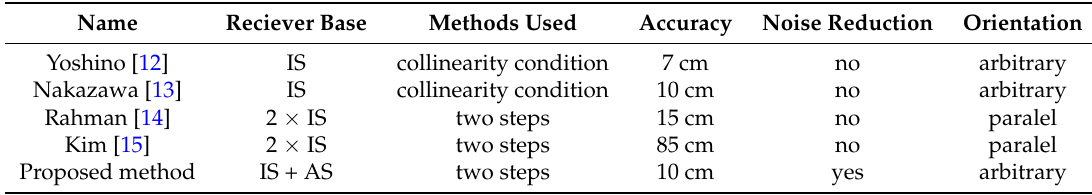
Table 3. VLC-based positioning algorithms using